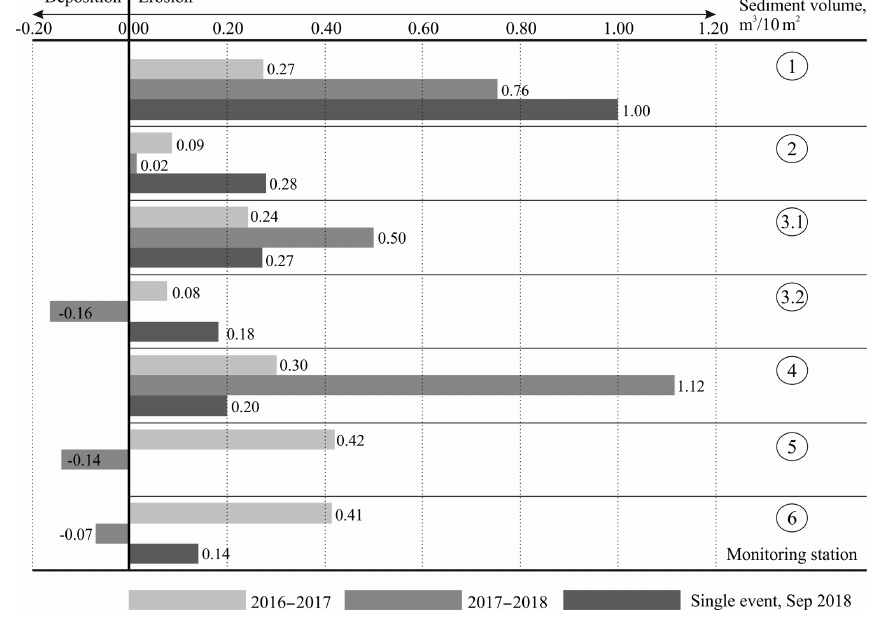
Figure 7. Volumes of mobilized material over the observation periods. Table 3. Total volumes of displaced material along the studied river reach. Channel bank type Total length of all segments,